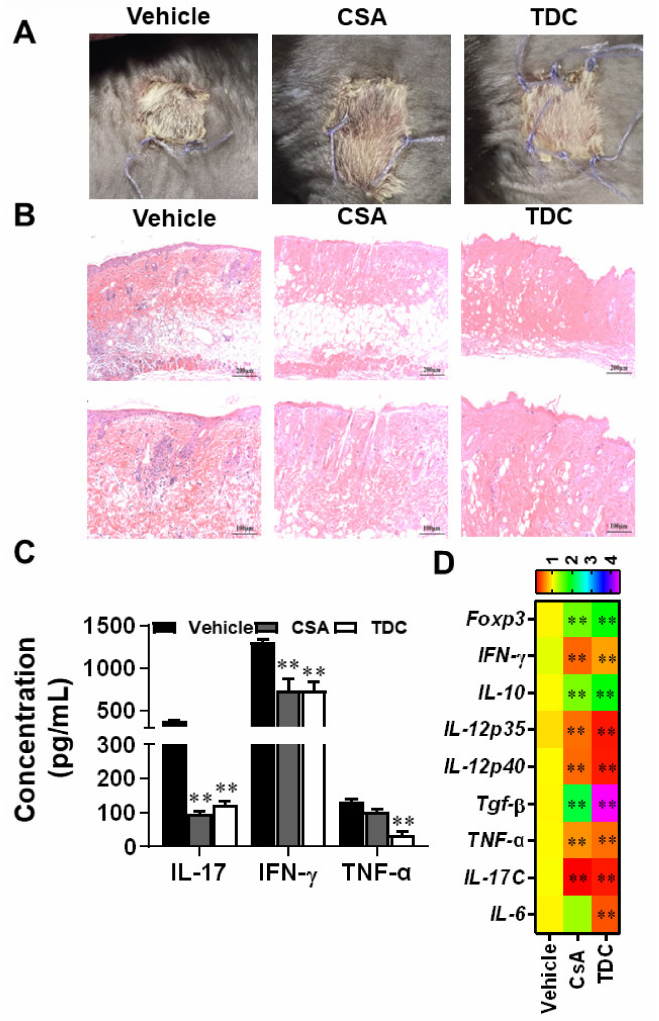
Figure 6. TDC treatment prevented skin allograft rejection. ( A ) The macroscopic aspect of the skin graft 7 days after the skin graft. ( B ) H&E staining of grafted skin slices 7 days after skin transplantation. Scale bar = 200 µ m (upper row) or 100 µ m (lower row). ( C ) The production of IL-17, IFN- γ and TNF- α in the supernatant of splenocyte culture was detected by ELISA. ( D ) qRT-PCR was performed to test the pro-inflammatory genes in the skin grafts of mice. Data are shown as mean ± SD ( n = 3 each group). ** p < 0.01, one-way ANOVA with multiple comparisons test ( C ) or unpaired Student’s t test ( D